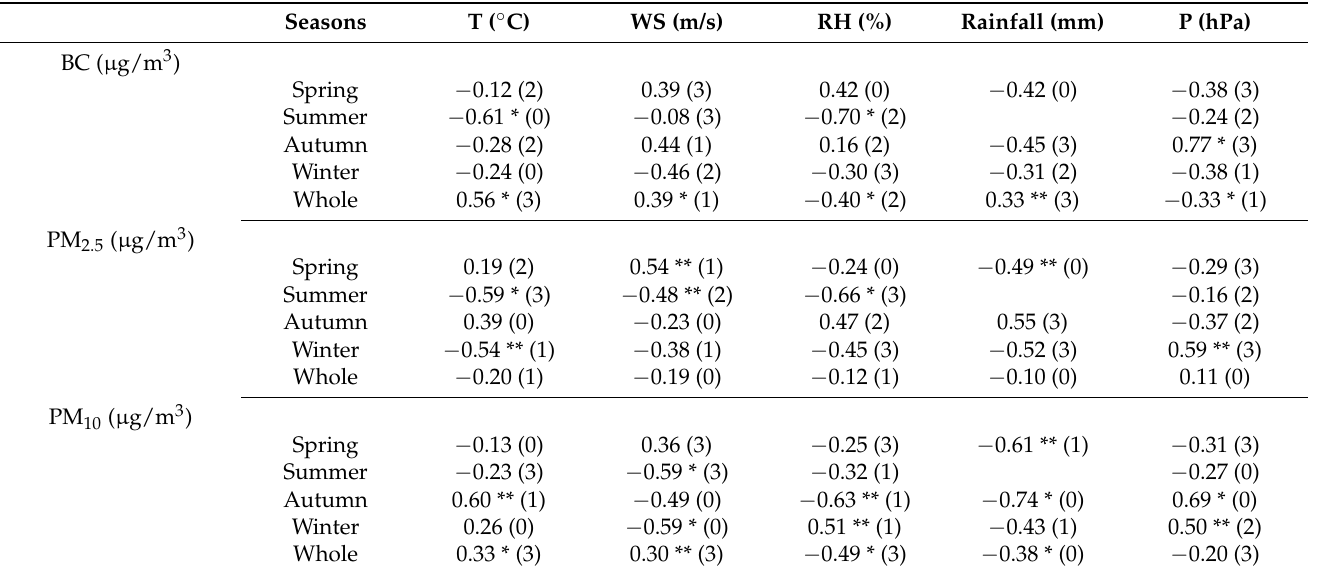
Table 2. Spearman correlation coefficient between meteorological and air pollution variables